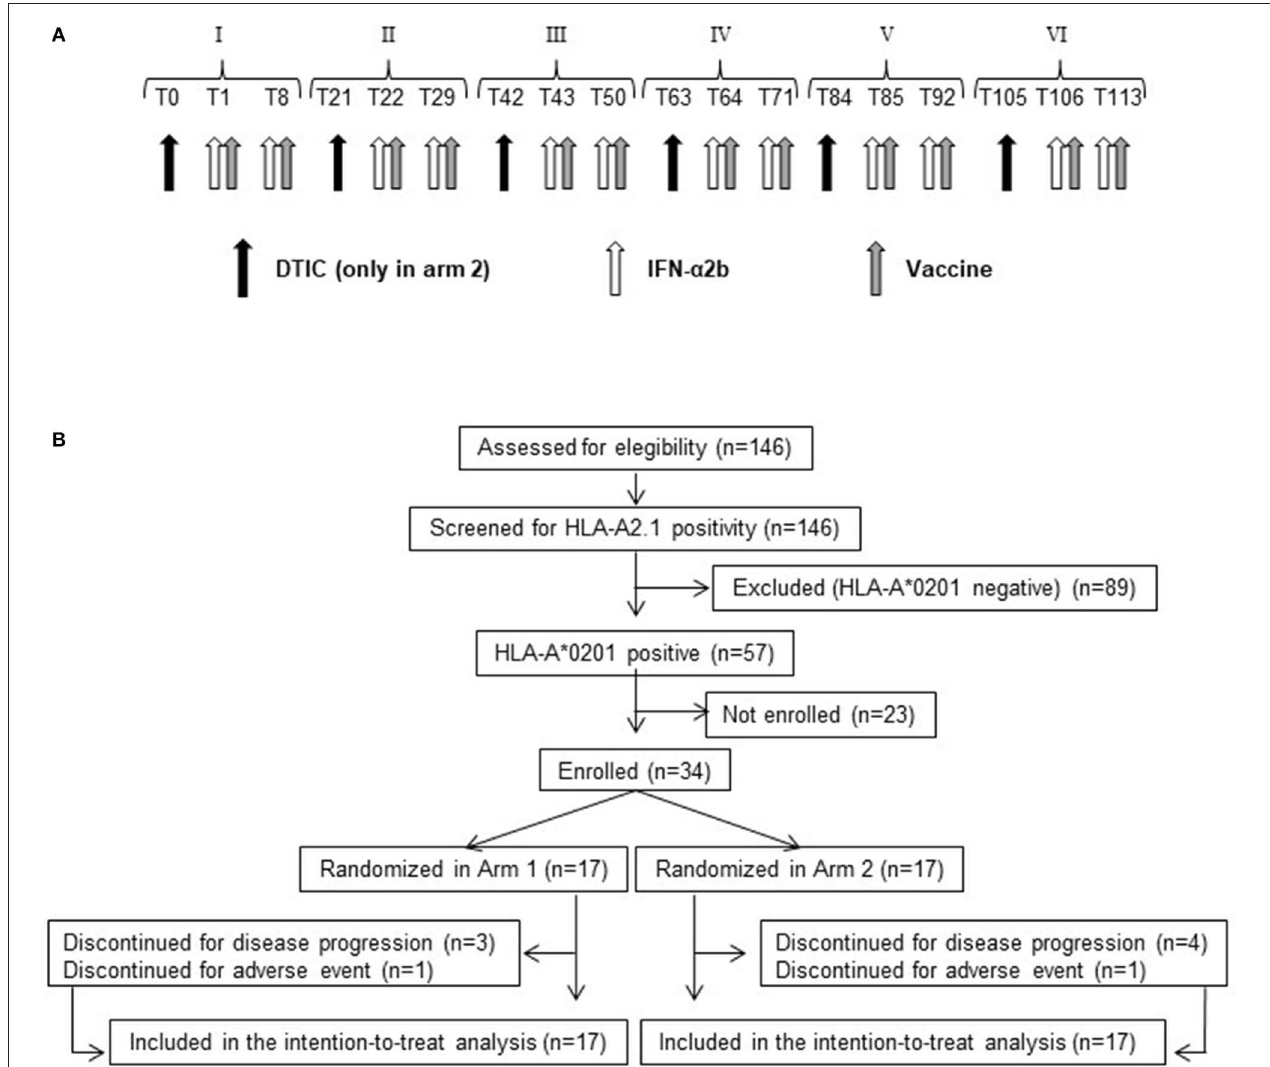
FIGURE 1 | Treatment schedule and CONSORT flow diagram. (A) Roman numbers indicate the cycle of treatment. Tn indicates the day after beginning of treatment. Black arrow, dacarbazine (DTIC) intravenous infusion. White arrow, IFN- α 2b subcutaneous injection. Gray arrow, vaccine (Melan-A/MART-1 and NY-ESO-1 peptides emulsified with Montanide ISA-51) intradermal injection. (B) Flow diagram showing the progress of patients throughout the trial.